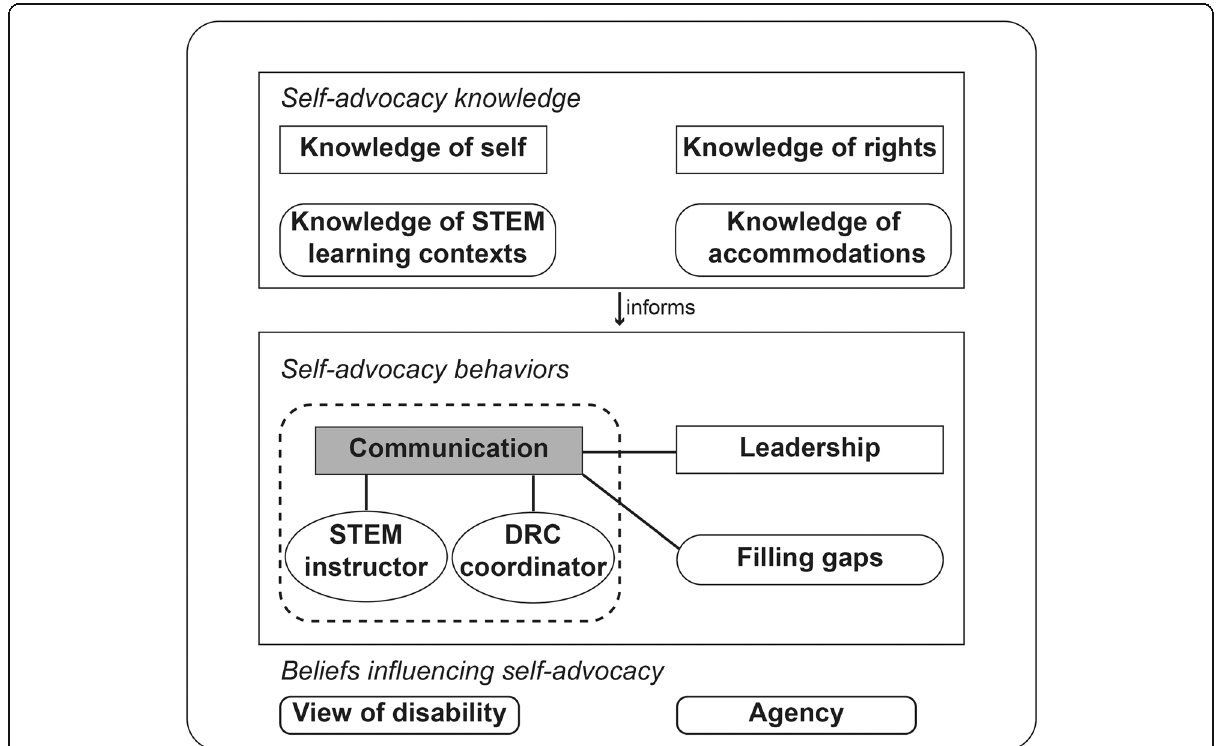
Fig. 2 Proposed model of self-advocacy for students with ADHD and/or SLD in the context of undergraduate STEM courses, based on our participants ’ experiences. Square-edged boxes represent components of Test ’ s conceptual framework (Test et al., 2005). Rounded-edged boxes represent emergent themes from our qualitative analysis. Ovals represent individuals our participants interacted with to practice self-advocacy. The shaded box represents a required component of self-advocacy. The dashed line box surrounding communication represents communication with STEM instructors and DRC coordinators. Lines connecting communication to leadership and filling gaps represent the integral role of communication in self-advocacy, e.g., communication is required for leadership and filling gaps. Components of self-advocacy can overlap due to their intersecting